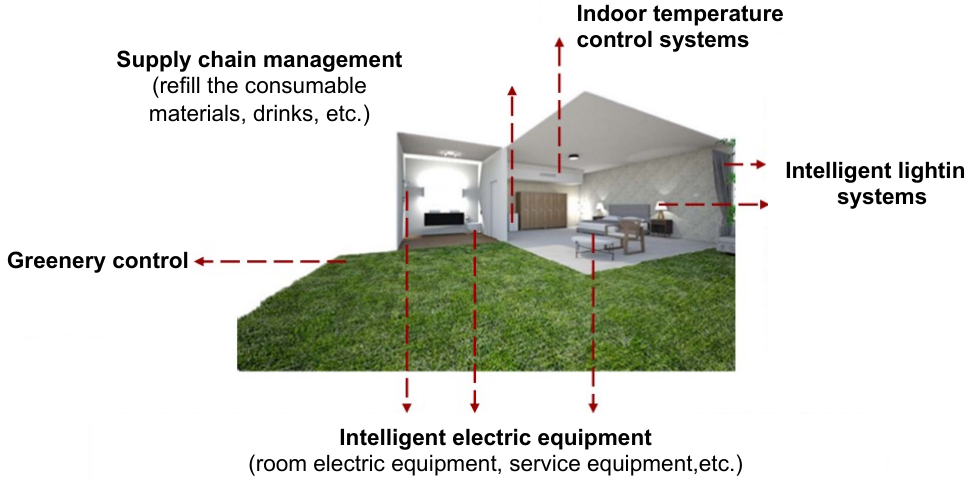
Figure 10. IoT improvements to the hotel user experience.